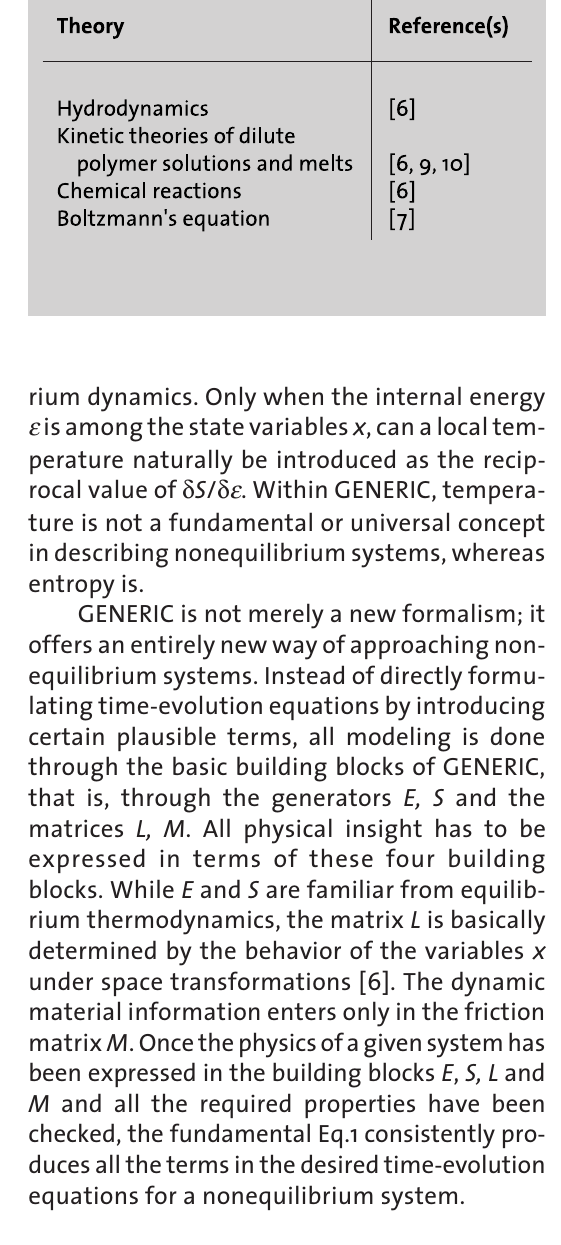
Table 1: Examples of Theories with GENERIC